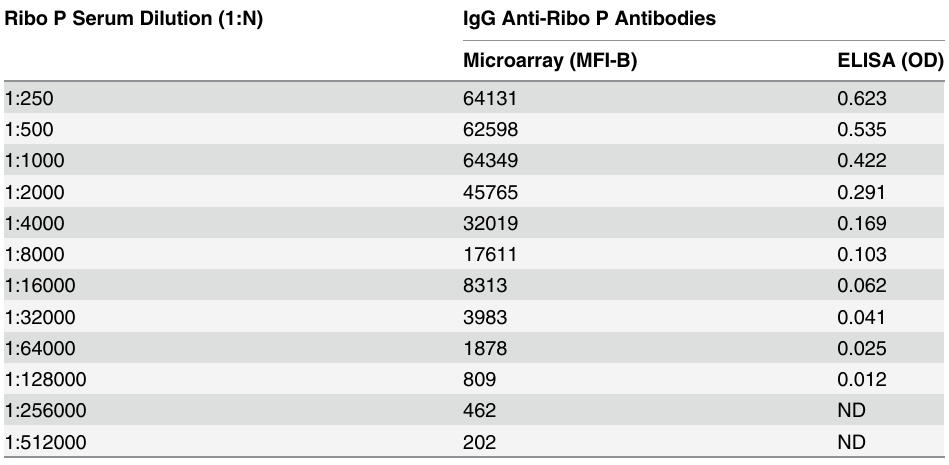
MFI-B, median fl uorescence intensity minus background for microarray features; OD, optical density; RiboP, ribosomal phosphoprotein P0; ND, not detected